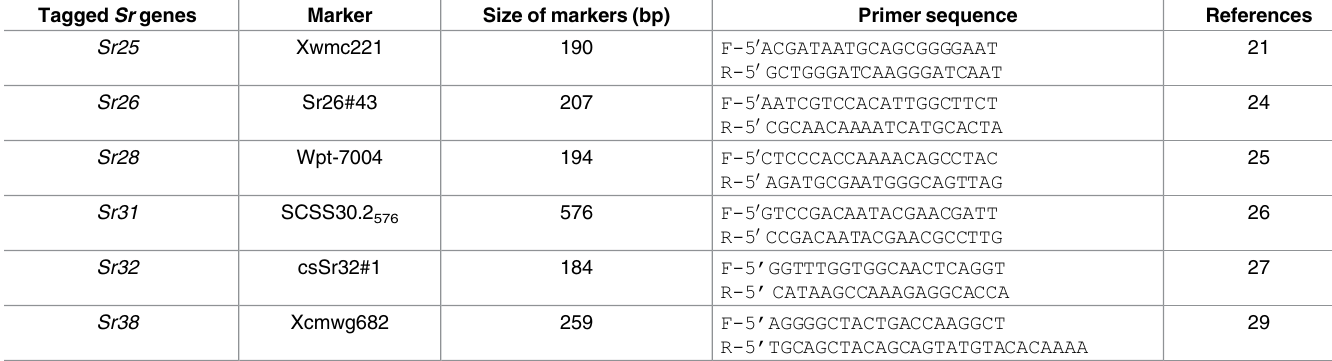
Table 2. The primers linked to resistance genes Sr25 , Sr26 , Sr28 , Sr31 , Sr32 and Sr38 . Tagged Sr genes Marker